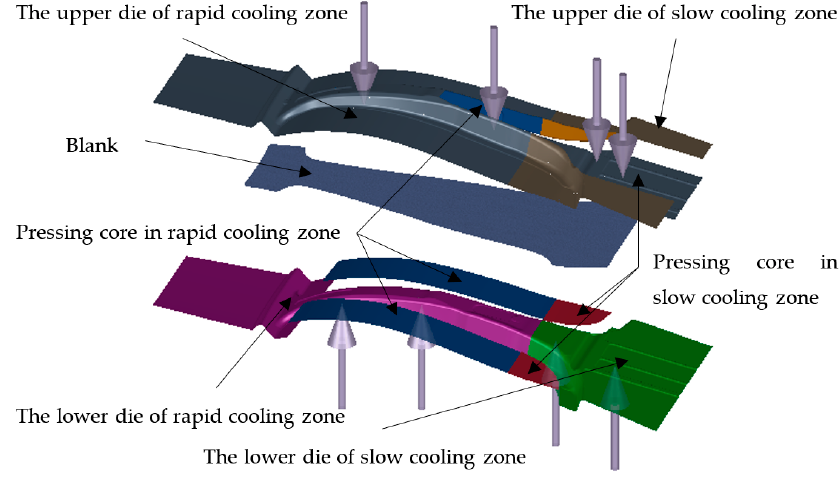
Figure 4. Simulation model.